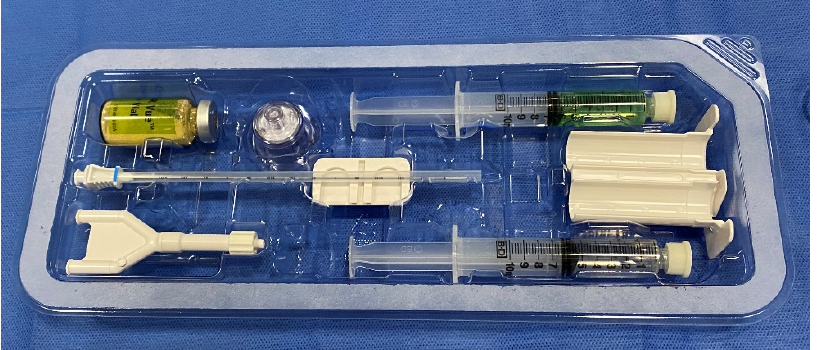
Figure 1. Contents of the SpaceOAR Vue. Dry PEG powder (yellow-colored powder, top left ) is reconstituted with a diluent (green-colored solution, top right ). A Y-connector ( bottom left ) and plastic syringe holder ( middle right ) connects the accelerant syringe ( bottom right ) to the PEG powder syringe.